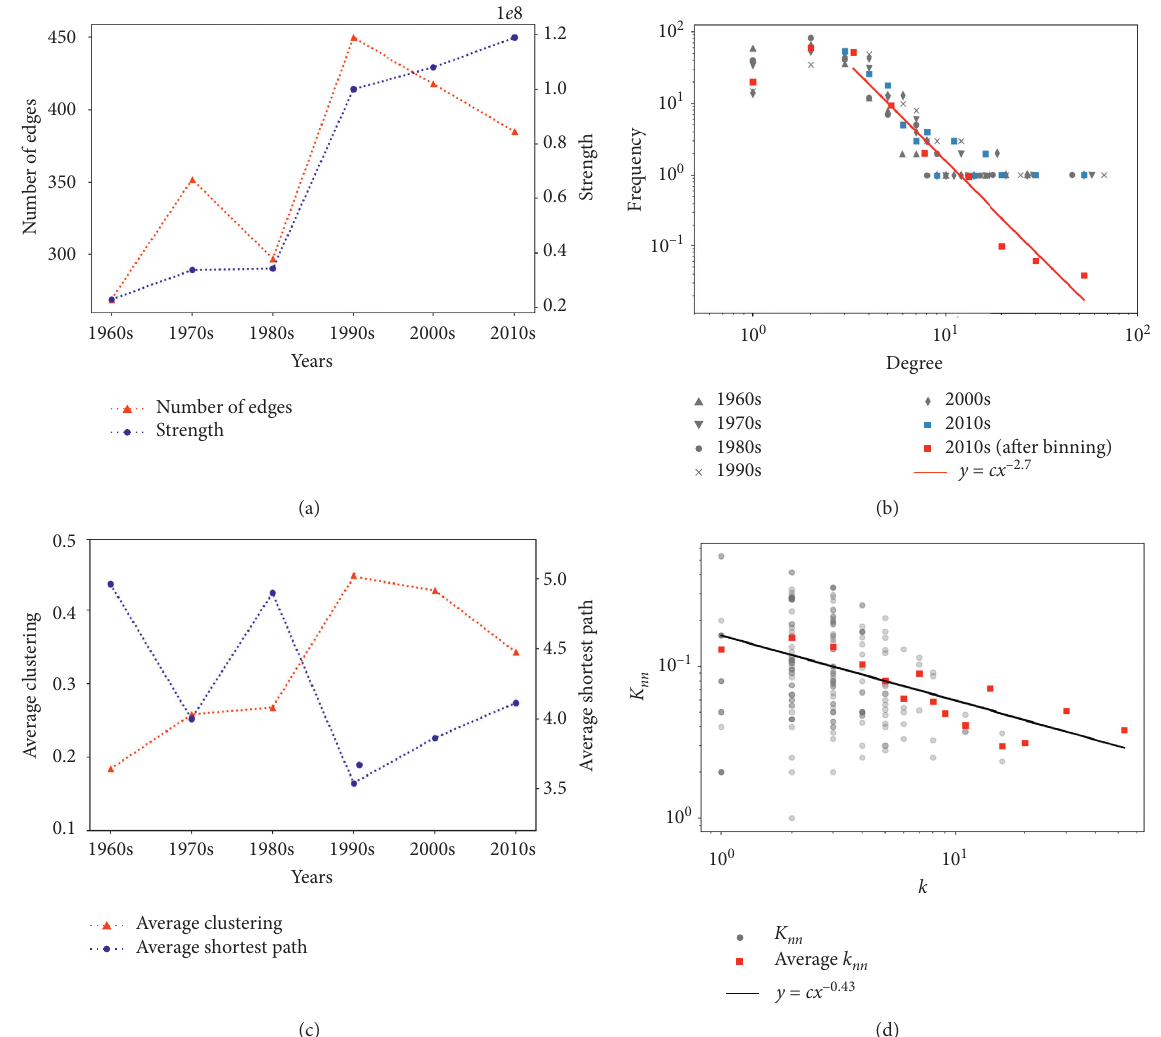
Figure 3: (a) Changes in the strength and numbers of edges of the backbone networks from 1960 to 2015. (b) The degree distribution of the backbone networks and power rate fitting of the population migration network for 2010–2015. The blue points are the original degree distribution, and the red points are the data after binning. (c) Changes in the clustering coefficients and the average shortest path of the backbone networks from 1960 to 2015. (d) Degree correlation of the migration network in 2010–2015.